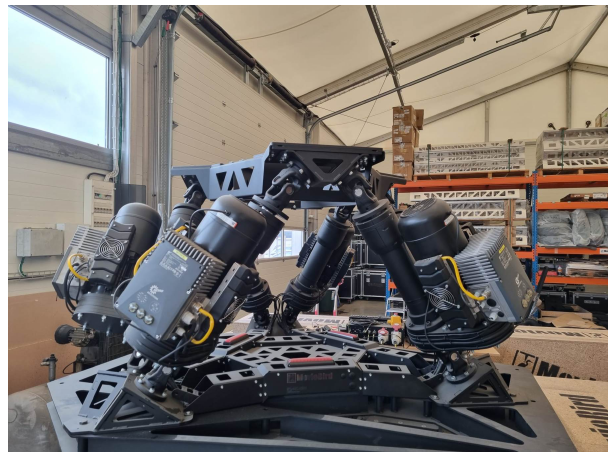
Figure 2. A real-life compensation system involving two Stewart platforms [Source: MovieBird